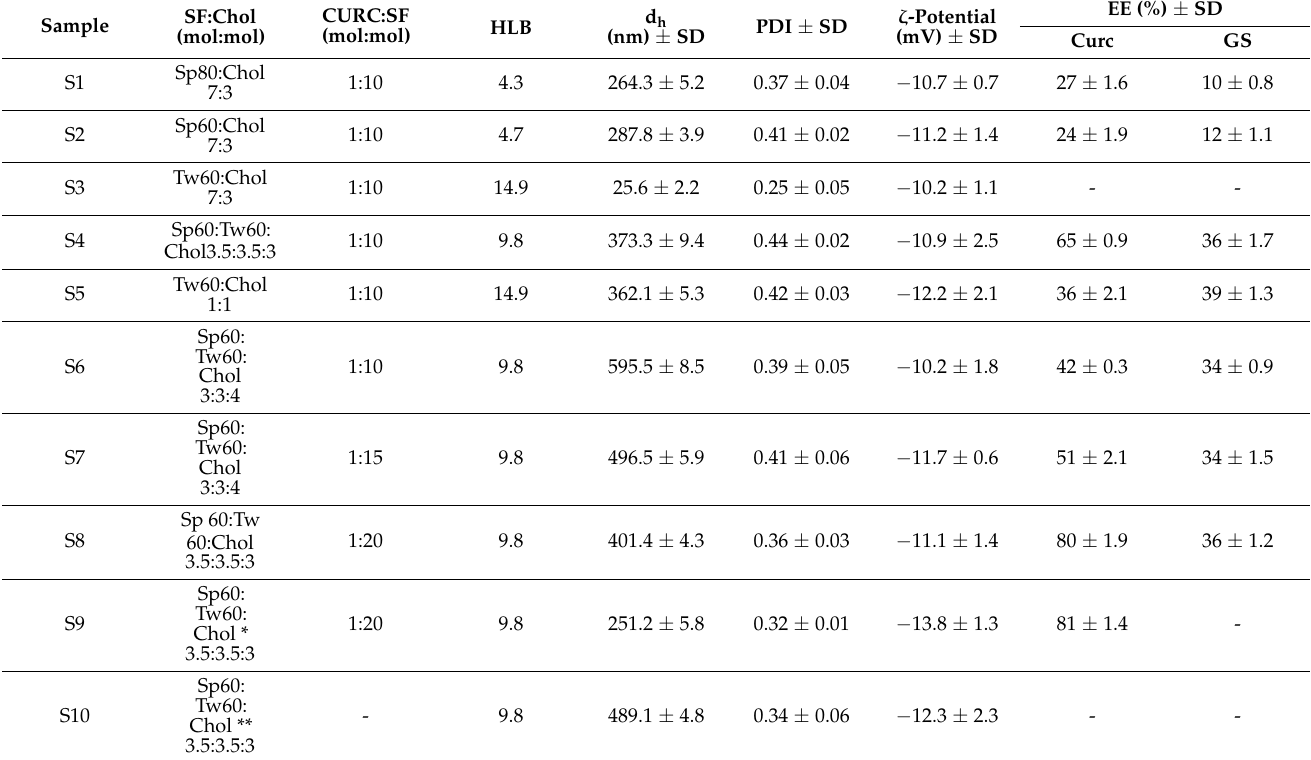
Table 1. Composition, physicochemical characteristics, and encapsulation efficacy of curcumin and gentamicin sulphate simultaneously loaded niosomes prepared by the thin film hydration method (TFH). In each of the formulations the concentration of gentamicin sulphate hydration solution is kept constant (26.86 µ mol/mL), while the CURC content varies from 1.5 µ mol/mL (at Curc:SF 1:20) to 3 µ mol/mL (at Curc:SF